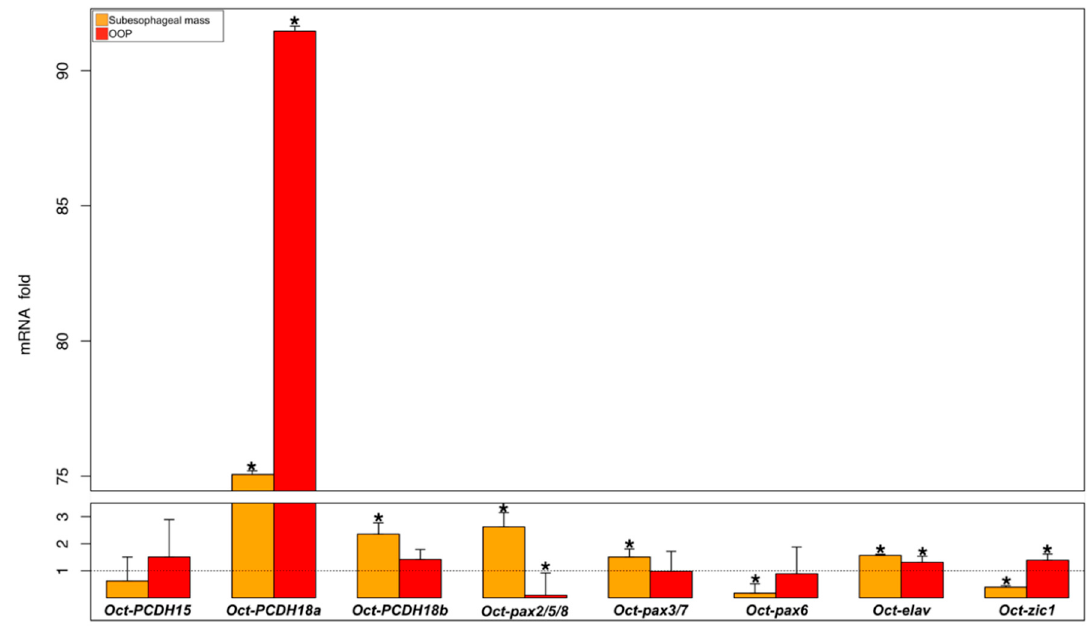
Figure 2. Gene expression analysis of different brain regions of the control animal group (N = 6). Relative mRNA fold change in gene expression in the subesophageal mass (orange) and OOP (red) compared to the supraesophageal mass (dot line set y = 1). * asterisk indicates that the difference vs. supraesophageal mass expression is statistically significant (Wilcoxon-test, p < 0.05). Error bars represent the SEM.